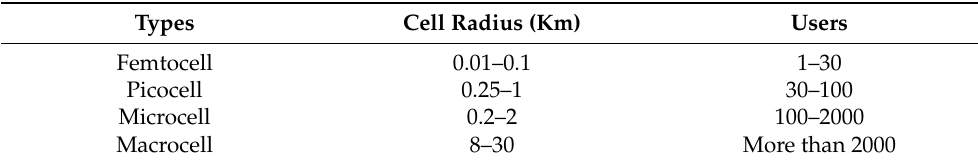
Table 5. Types of Small Cells and their Coverage Radii